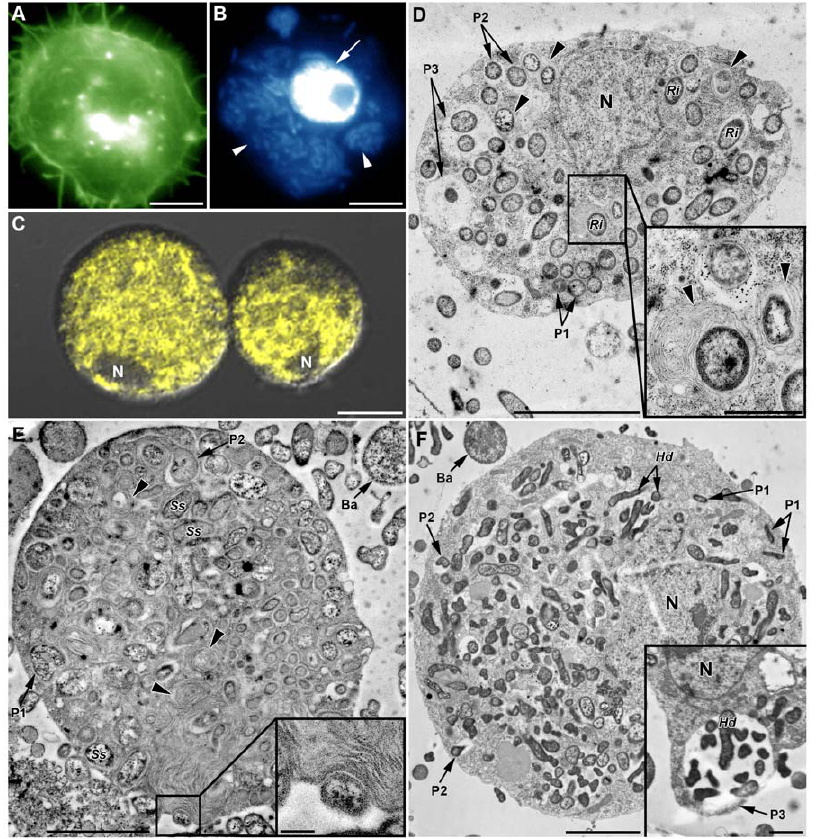
Figure 8. Invivo phagocytosis of symbionts by hemocytes from SS-containing YR2 lines. (A–C) Fluorescent micrographs of YR2(Ri) hemocytes. (A) F-actin (green) and (B) DNA staining (blue), of an adherent granulocyte. The cytoplasm is filled with R. insecticola secondary symbionts as shown by bacterial DNA staining (arrowheads in B; arrow: cell nucleus), and (C) specific FISH detection (yellow, false color; DIC and confocal micrographs overlay). Nucleus ( N ) location is detectable by the absence of yellow coloration. (D–F) TEM micrographs showing phagocytosis of secondary symbionts by hemocytes of three YR2 lines. (D) YR2(Ri) granulocyte containing numerous R. insecticola inside the cytoplasm. Different symbiont-containing phagosomal structures are observed ( P1 : zipper-like, P2 : trigger-like, P3 : macropinocytosis), as well as phagolysosomes containing symbionts and membranous material (arrowheads and box). (E) YR2-Ss line granulocyte with numerous S. symbiotica inside cytoplasmic membranous phagolysosomes (arrowheads). Insert box: detail of S. symbiotica engulfment by trigger-like phagocytosis. (F) YR2-Hd granulocyte containing H. defensa symbionts in the three types of phagosomes. Inset: plasmatocyte with a large phagosome structure (macropinocytosis-like) enclosing several symbionts and extracellular fluid. Scale bar: 5 m m (A–B), 10 m m (C), 5 m m (D), 2 m m (F) and 1 m m (magnifications boxes in (D) and (E)).